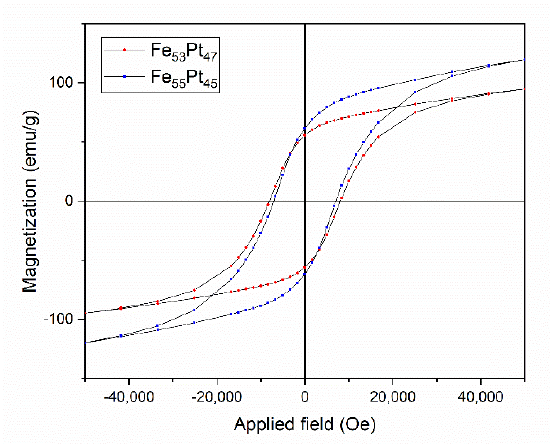
Figure 8. The 27 ◦ C hysteresis loops of the Fe 55 Pt 45 and Fe 53 Pt 47 samples annealed at 500 ◦ Figure 8. The 27 °C hysteresis loops of the Fe 55 Pt 45 and Fe 53 Pt 47 samples annealed at 500 °C.